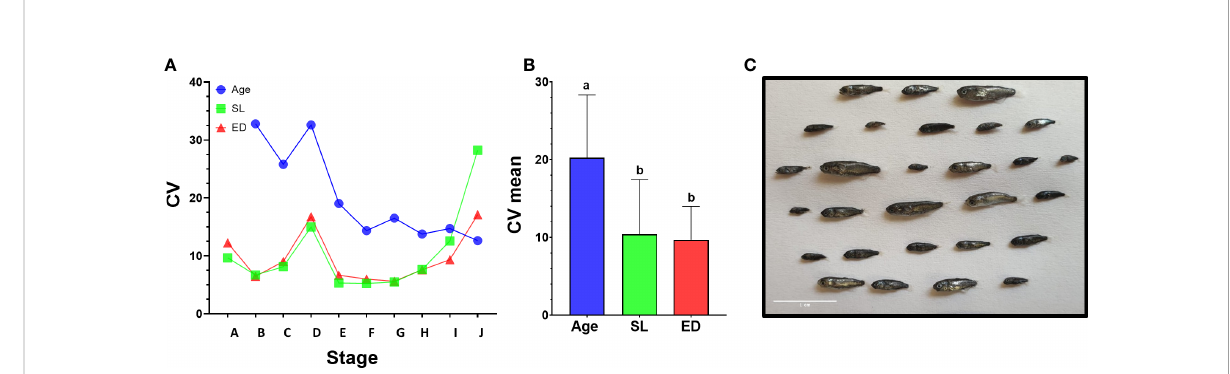
FIGURE 5 Variance of morphometric parameters during development. (A) Coef fi cient of variance analysis of age, SL and ED. CV was calculated on larvae from the same developmental stage in batches A and D that encompass the entire larval period. In stages A to I, age shows higher CV values than SL or ED. (B) Comparison of mean CV for all stages using Tukey-Kramer hsd. Different letters mark means which differ signi fi cantly ( a =0.05). (C) Size variation of mullet larvae at 26 dph (batch A). Scale bar-1